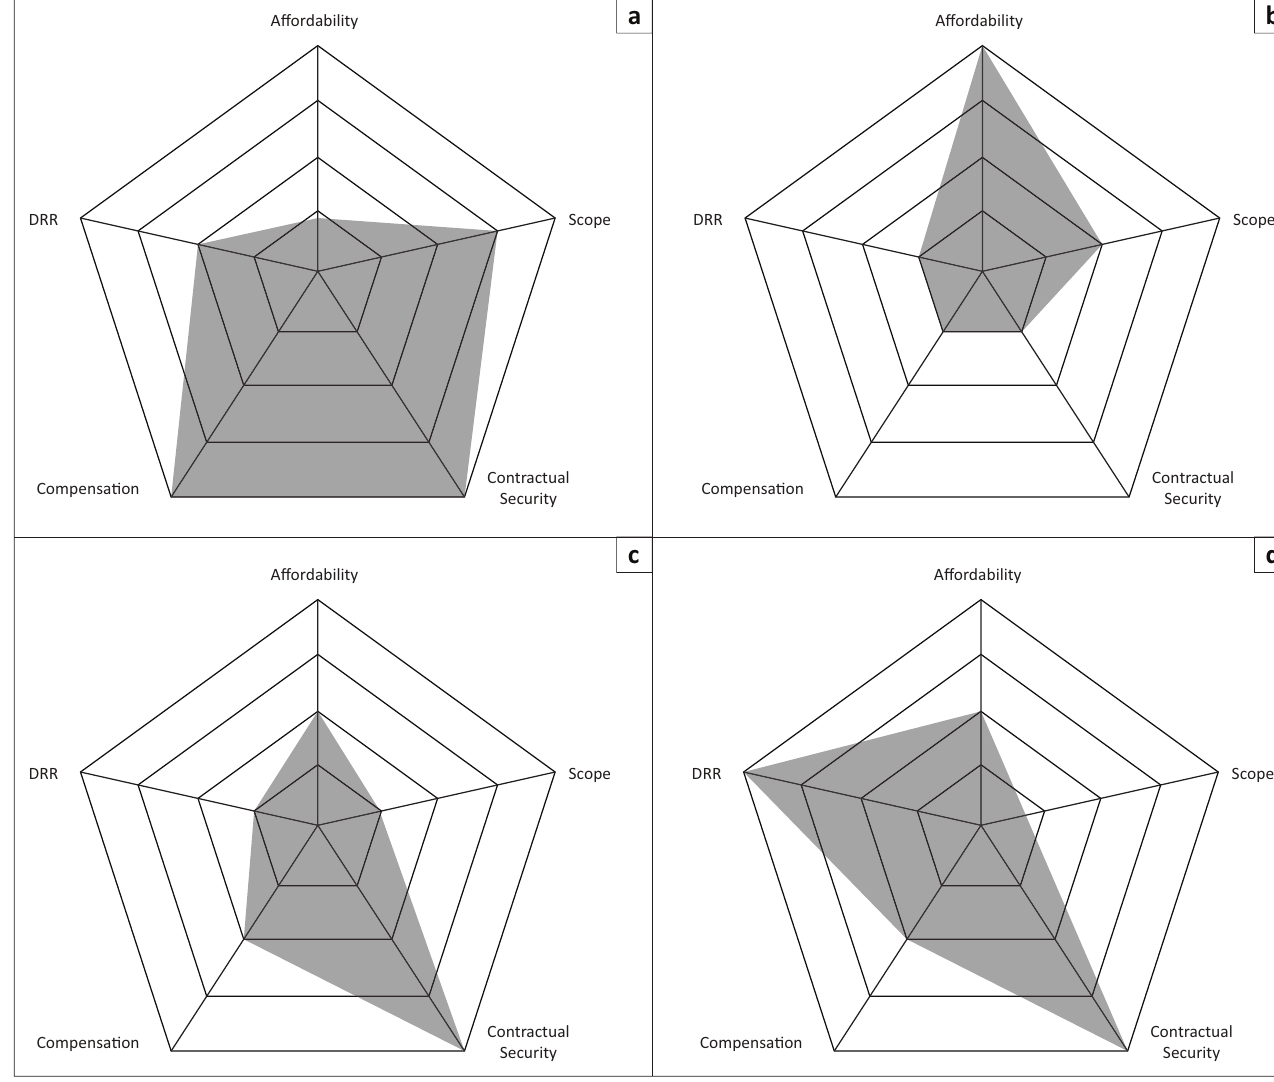
FIGURE 2: Radar charts for private insurance mechanisms. (a) Private individual policies (QBE Vanuatu), (b) risk retention, (c) micro insurance (Rashtriya Krishi Bima Yojana) and (d) social safety net (Horn of Africa Risk Transfer for